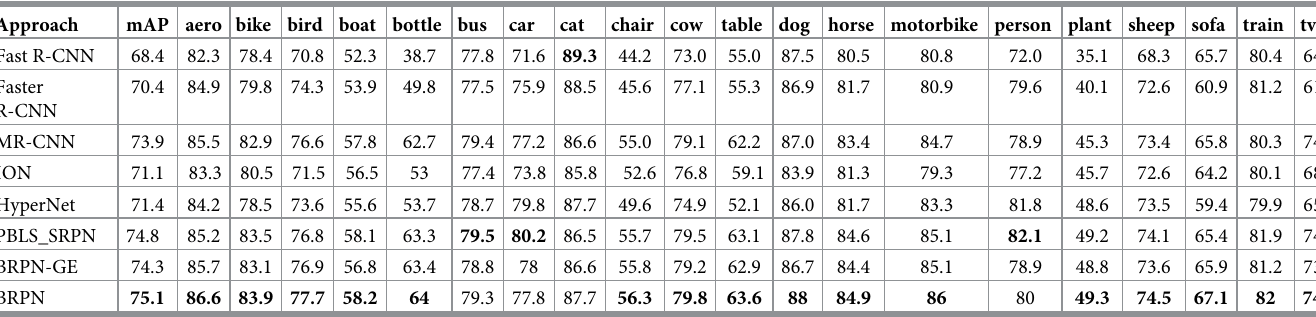
The best AP of each object category and mAP are highlighted in bold.